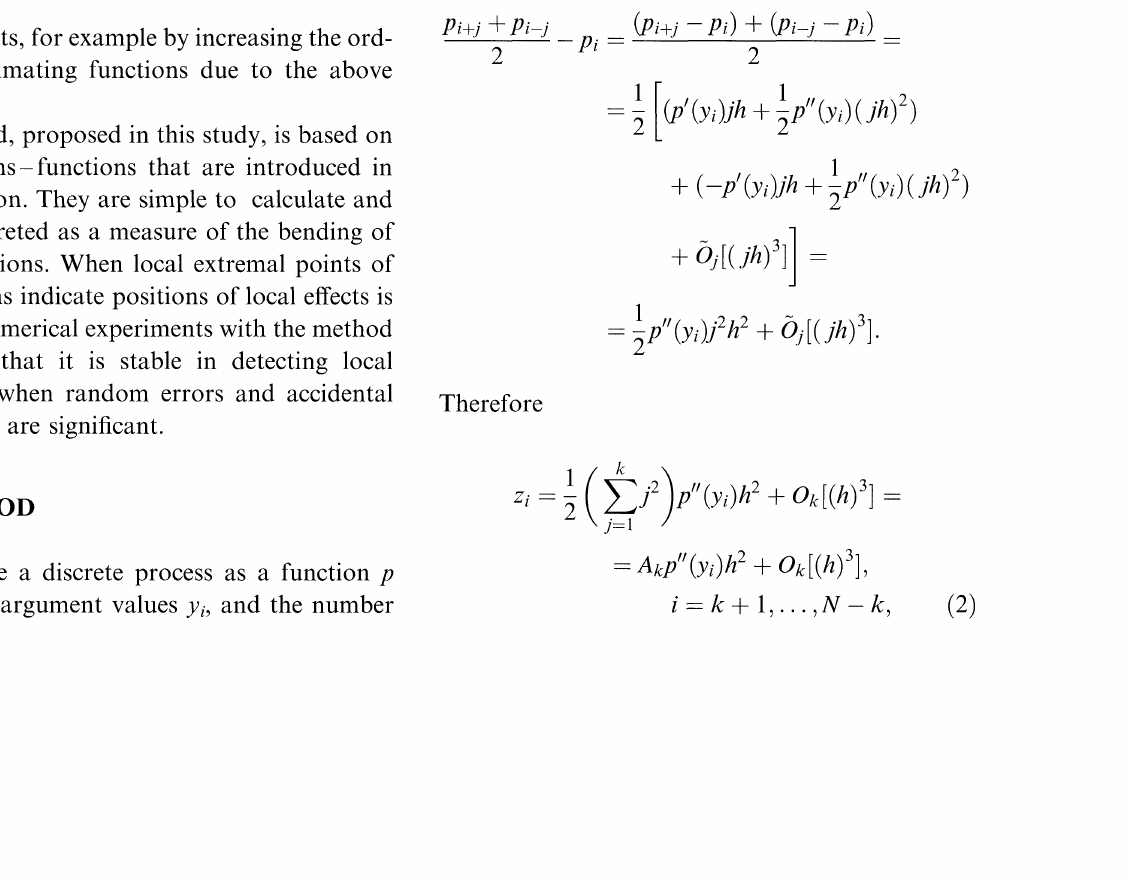
FIGURE 3 Absorption characteristics (@ Drury,